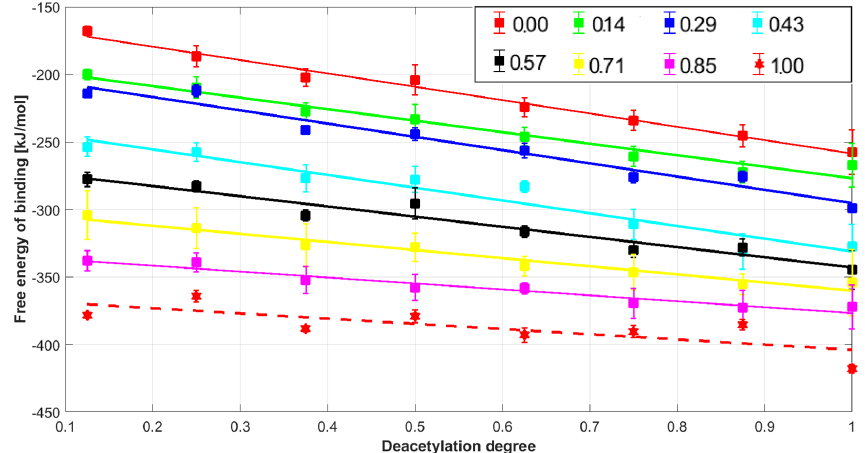
Figure 2. Free energy of chitosan-collagen binding as a function of both chitosan deacetylation degree (DD) and the hydroxylation degree HD. Molecules 2023 , 28 , x FOR PEER REVIEW